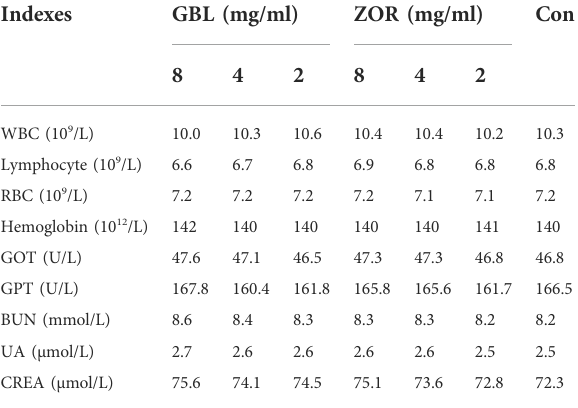
TABLE 1 Effects of extracts of G. biloba leaves (GBL) and Z. of fi cinale rhizome (ZOR) on aged mice ’ blood